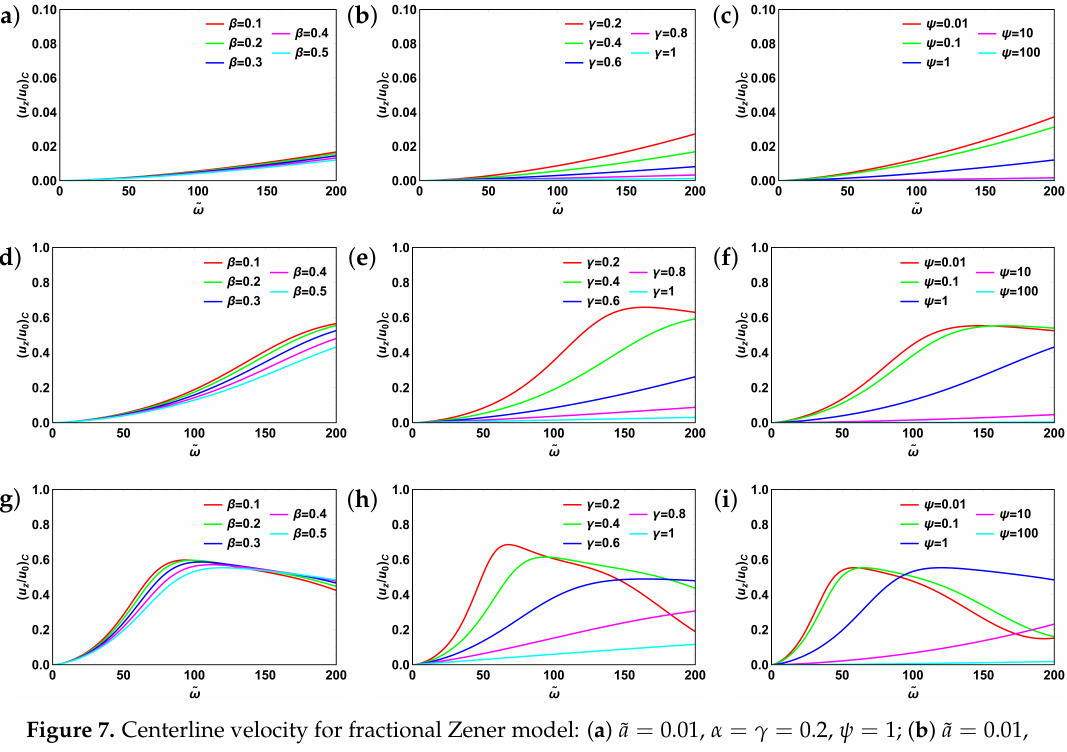
Figure 7. Centerline velocity for fractional Zener model: ( a ) ˜ a = 0.01, α = γ = 0.2, ψ = 1; ( b ) ˜ a = 0.01, α = β = 0.5, ψ = 1; ( c ) ˜ a = 0.01, α = β = γ = 0.5; ( d ) ˜ a = 0.05, α = γ = 0.2, ψ = 1; ( e ) ˜ a = 0.05, α = β = 0.5, ψ = 1; ( f ) ˜ a = 0.05, α = β = γ = 0.5; ( g ) ˜ a = 0.1, α = γ = 0.2, ψ = 1; ( h ) ˜ a = 0.1, α = β = 0.5, ψ = 1; ( i ) ˜ a = 0.1, α = β = γ = 0.5. Subscript “c” stands for